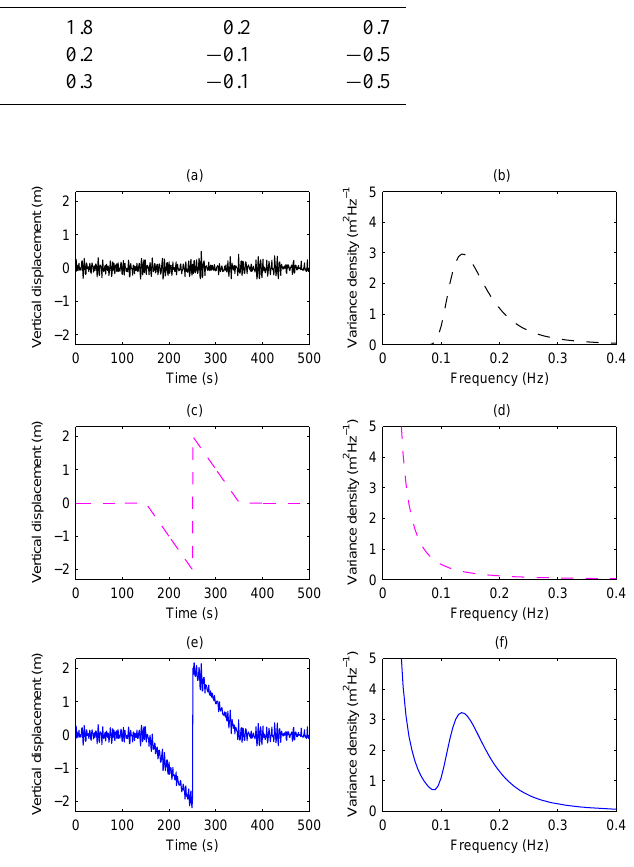
Figure 2. A schematic illustration of signal and the frequency re- sponse of a clean time series (a–b) , a sawtooth wave (c–d) and the combined time series (e–f) . The wave spectrum (f) of the combined signal is just a superimposition of the wave spectra (b, d) of the individual